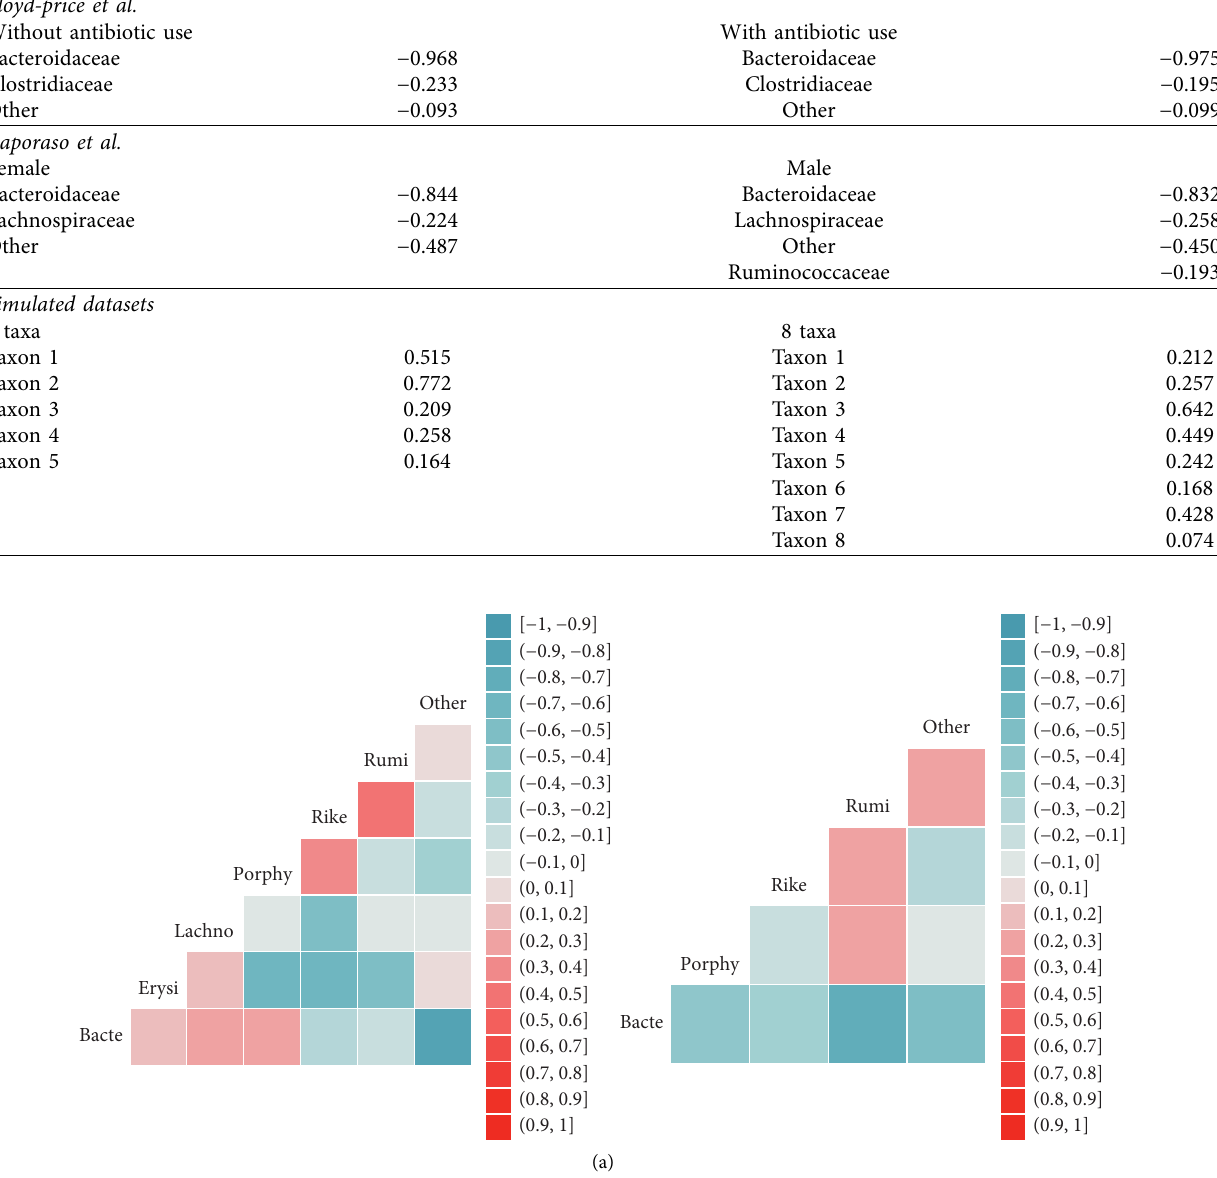
Table 5: MTA output related to the contribution of each taxon to the longitudinal microbial profiling in real and simulated datasets,